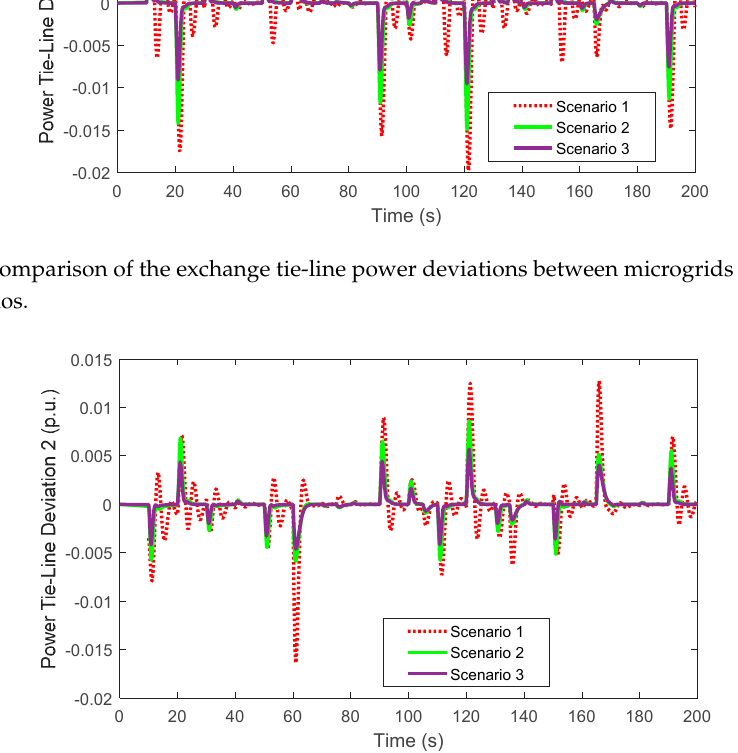
Figure 15. Comparison of the exchange tie-line power deviations between microgrids 2 and 3 in the three scenarios.